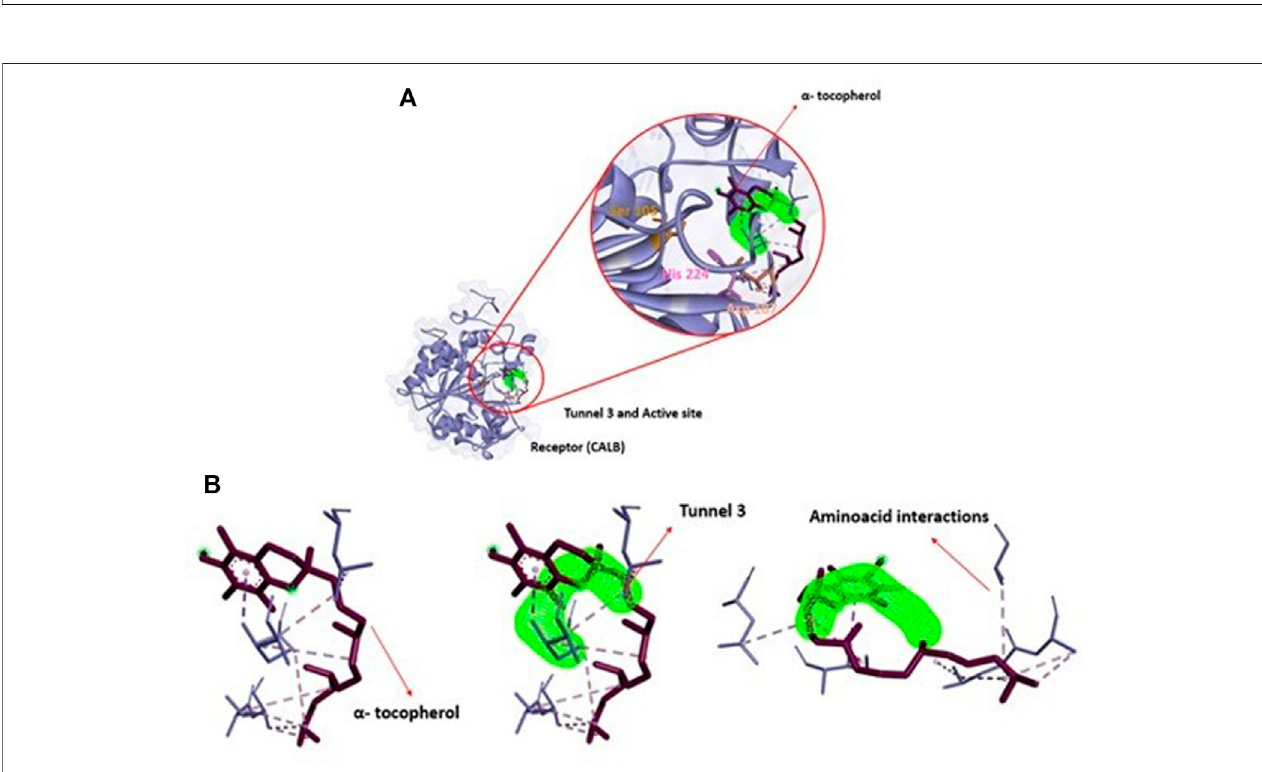
FIGURE 7 | (A) : Structural representation of receptor (CALB), active site (Ser 105, Asp 187 and His 224) in relation to position of tunnel 3 and the ligand ( α -tocopherol). (B) : View of ligand α -tocopherol (purple) in tunnel 3 (green) apllied Caver Web in protein.